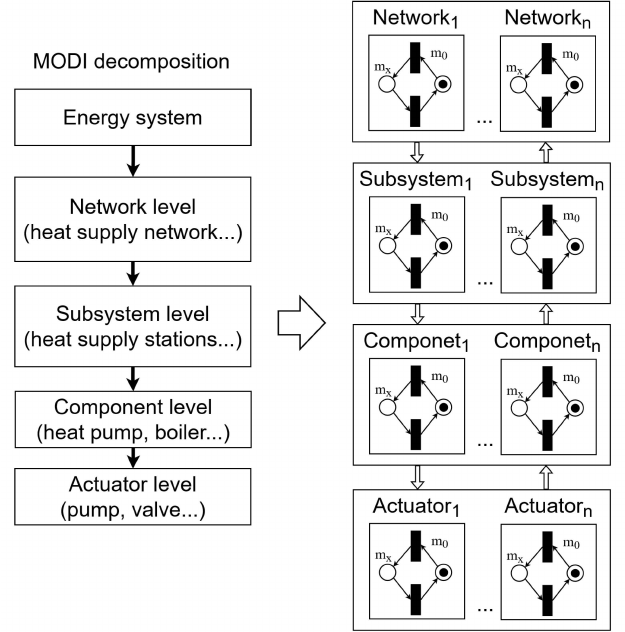
Figure 4. A hierarchical framework of signal-interpreted Petri nets for modeling a mode-based control strategy corresponding to the standard decomposition structure of the